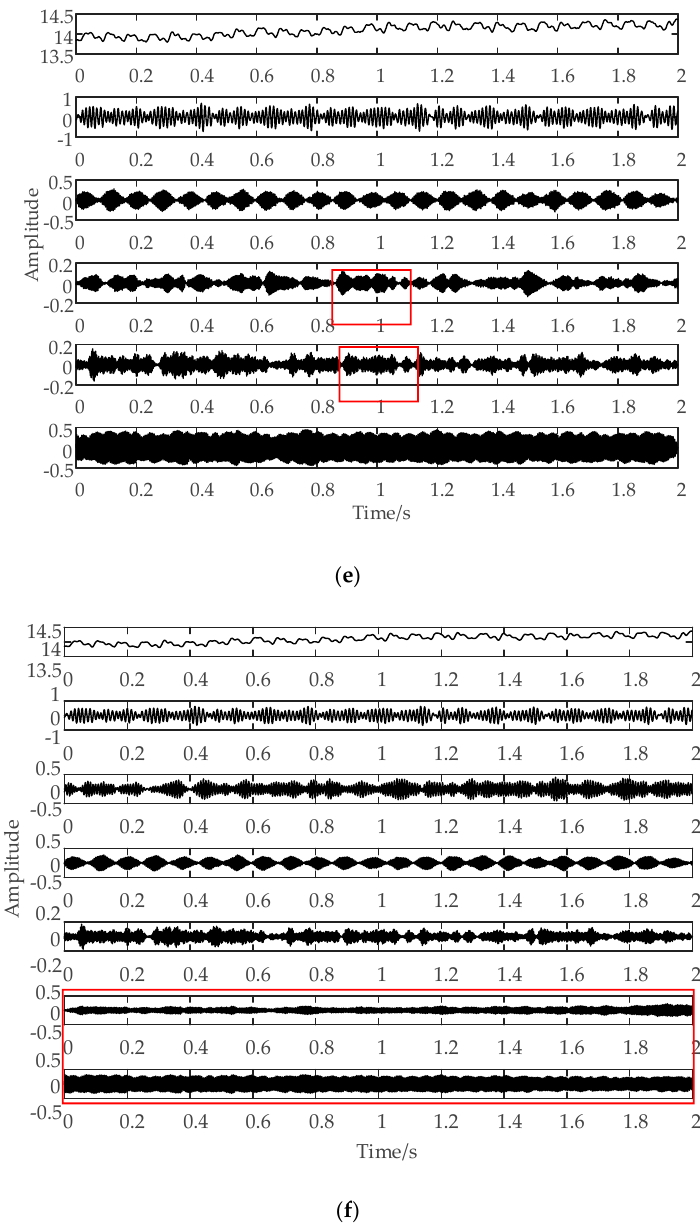
Figure 5. The variational mode decomposition (VMD) result of the current signal under different K values: ( a ) K = 2, ( b ) K = 3, ( c ) K = 4, ( d ) K = 5, ( e ) K = 6, and ( f ) K = 7.